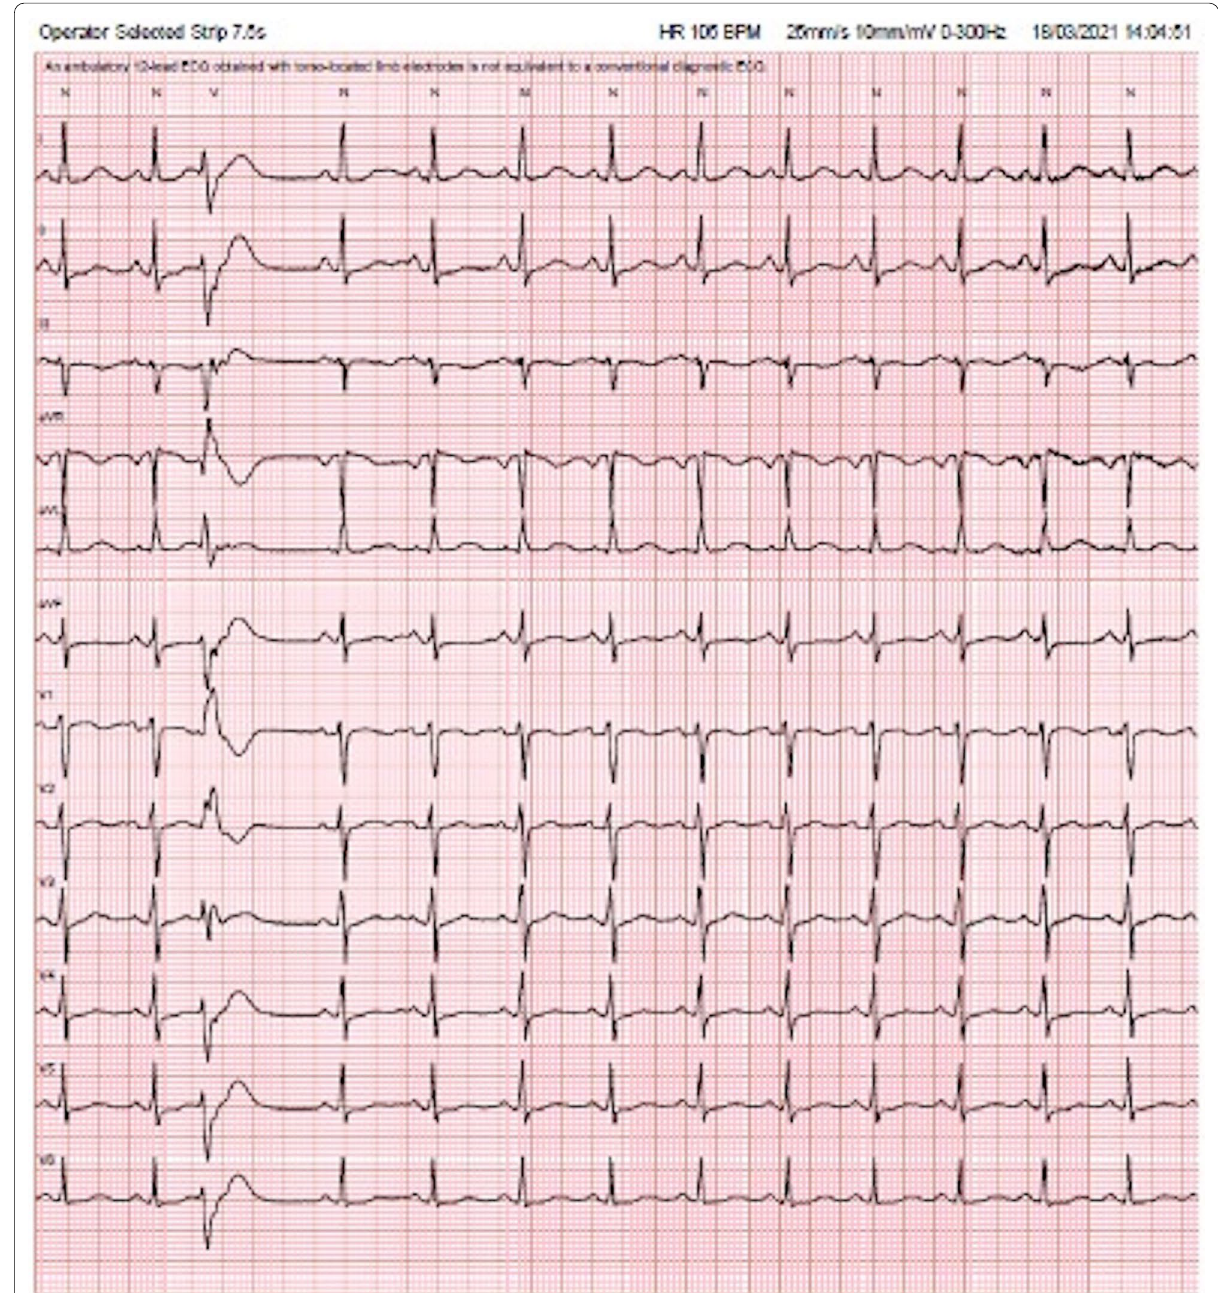
Fig. 1 Sinus rhythm with normal QRS complexes and intervals and a single VE of RBBB-right superior axis morphology, demonstrating the r > R ′ pattern in V1 and V2 (suggests fascicular